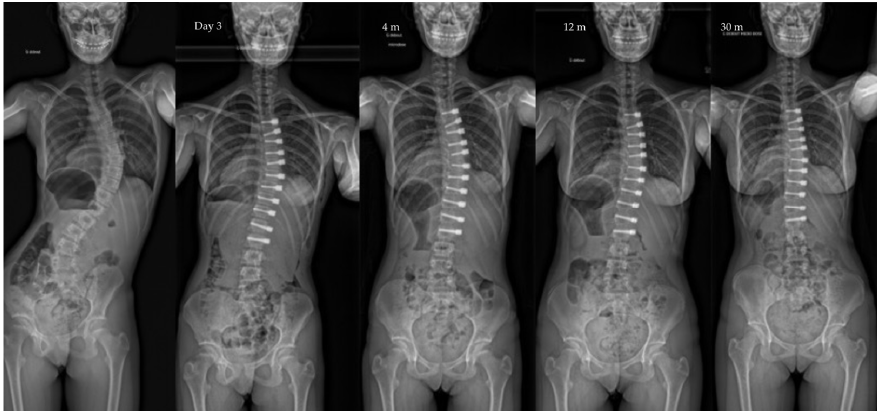
Figure 5. Radiographs of a 12.5-year-old patient, Risser 0, with a main long thoracic curve (lower end vertebra at L3. The major curve measured 57° pre-operatively and improved to 27° after surgery. Note the progressive frontal rebalance due to the thoraco-lumbar growth modulation. At last follow-up (2.5 y po), the major curve was measured at 9°. Table 4. Comparison of the main published series on VBT in AIS. (OC: overcorrection; PTX: